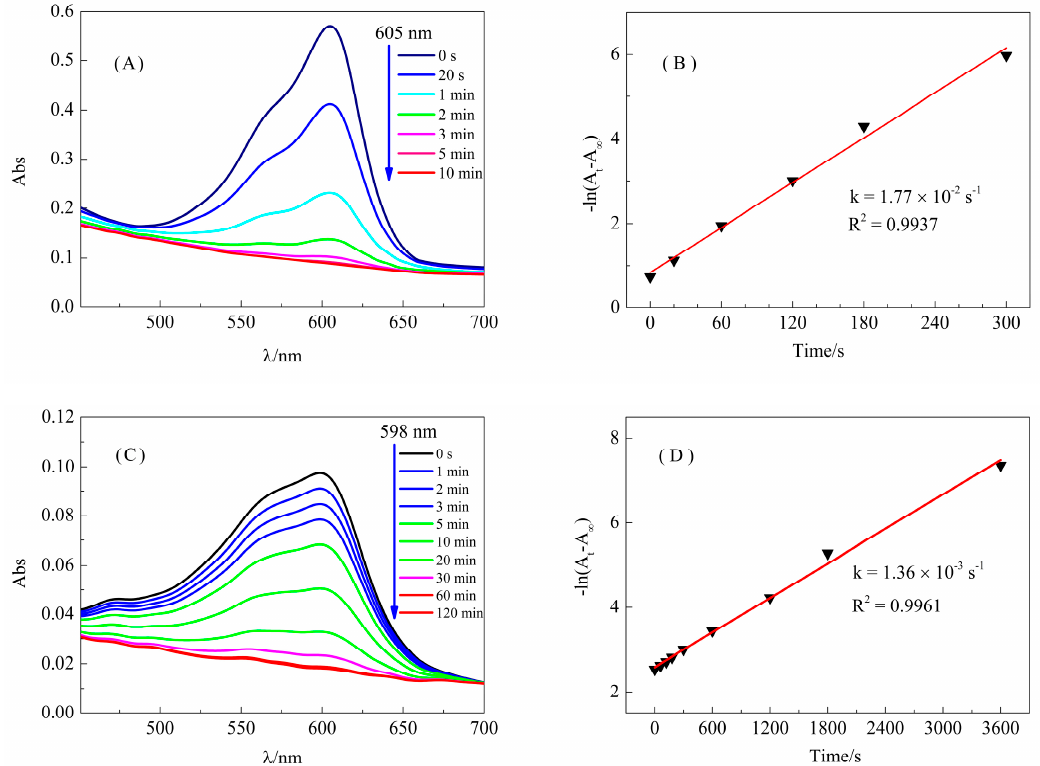
Figure 9. Absorption spectra during thermal color decay of the colored form of NC-g-AISO in ethyl acetate ( A ), in solid membrane ( C ) and the first-order thermal color decay kinetic curve in ethyl acetate ( B ), in solid membrane ( D ).